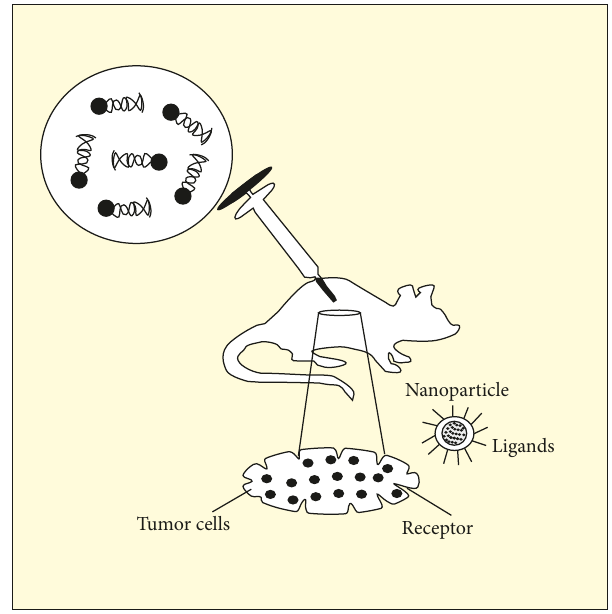
Figure 2: The mechanism of active tumor targeting of magnetic nanoparticles. The active tumor targeting of nanoparticles has been in practice in current era in albino mice. The ligands are attached to the outer surface of nanoparticles. The desired anticancer drug is attached to the outer surface of the site specific nanoparticles which recognize and ensure the efficient entry of the drug to the tumor cell reducing the toxicity in the neighbouring normal